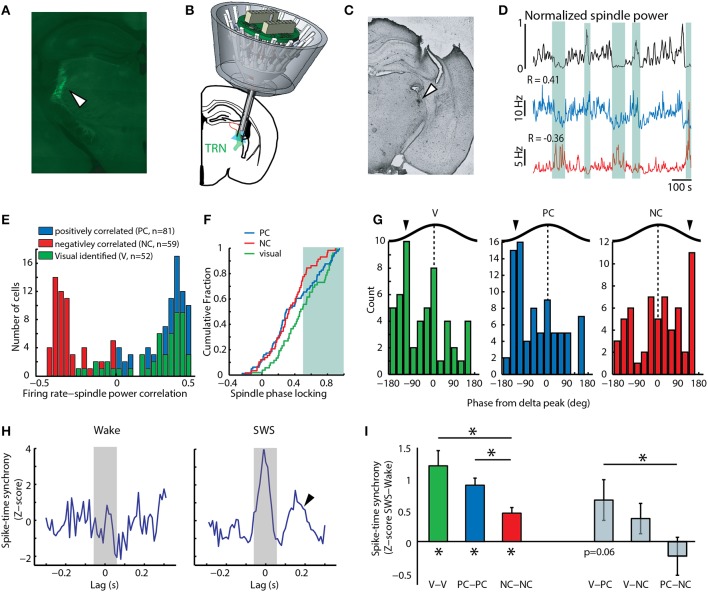
Positive correlation to spindles among TRN neurons predicts involvement in sensory processing. (A) Histological section showing Cre-dependent retrograde tagging of visTRN. (B) Cartoon depiction of multi-electrode implant with optical fiber targeting caudal TRN, where visTRN neurons are located. (C) Histological verification of TRN targeting in one mouse. (D) Examples of two untagged TRN neurons displaying positive (blue) and negative (red) correlation to spindle power (black). Shaded areas highlight portions of high or low spindle power and the opposing changes in firing rate between the positive and negative correlated example neurons. (E) Population data reveals a bimodal distribution of rate-spindle power correlation among TRN populations (PC, n = 81; NC, n = 59), with visTRN neurons (n = 52) exhibiting a predominantly positive correlation. (F) visTRN neurons show higher spindle phase locking values compared to NC neurons. PC neurons are more visTRN-like at higher phase-locking values (shaded area). (G) visTRN and PC neurons show similar phase preferences to delta waves in sleep, which is opposite to NC neurons. (H) Example spike-time synchrony (Z-score) plot from a PC neuronal pair, showing elevated values in SWS compared to wake. Only the integral of the correlation value [−50, 50] ms (shaded area) was taking into account for quantification. Arrow head denotes second peak at 200 ms, suggestive of delta entrainment. (I) Group data of quantifying phenomenon in panel h; note that visTRN and PC populations exhibit the highest synchrony values, and both are significantly different than NC neurons (*P < 0.05, Wilcoxon rank-sum test). When comparing across group, visTRN and PC heterologous pairs are the only ones that show a value of marginal significance (P = 0.06, Wilcoxon signed-rank test).